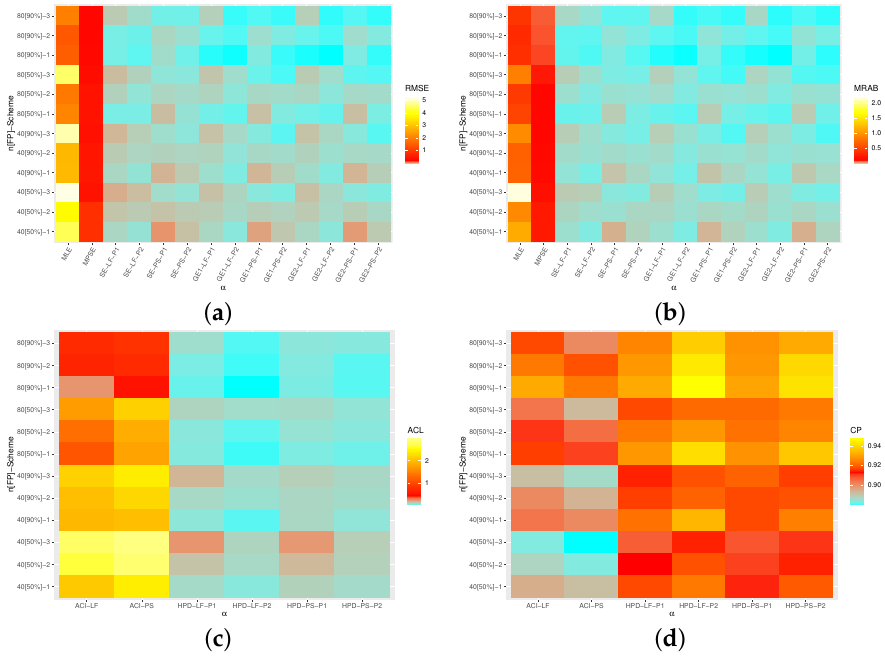
Figure 5. Heatmap for the simulation results of α . (a) RMSE. (b) MRAB. (c) ACL. (d) CP.